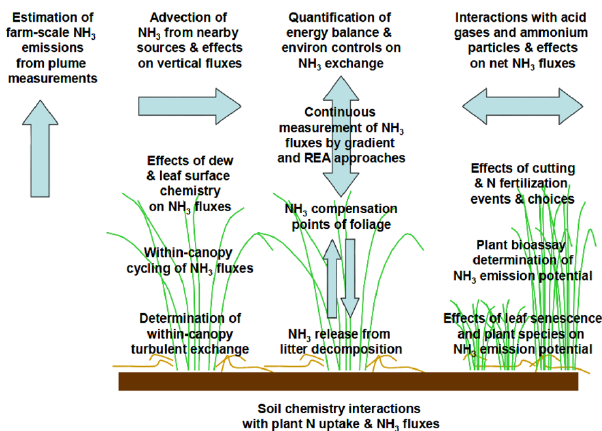
Fig. 4. Overview of processes controlling surface/atmosphere NH 3 exchange in the soil-vegetation-atmosphere continuum, summaris- ing the scientific objectives of the GRAMINAE integrated exper- iment (from Sutton et al., 2009a), but relevant for NH 3 exchange studies in any